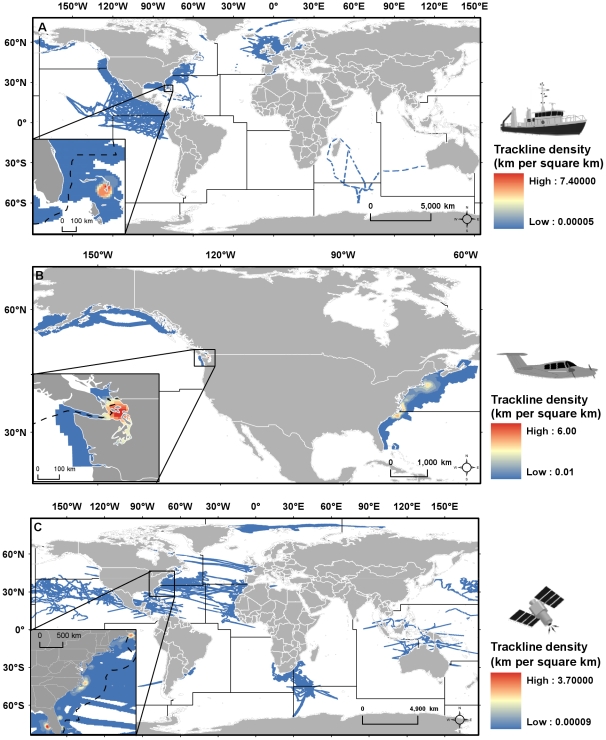
Relative density of tracklines published on SEAMAP for global FAO regions.Trackline data collected by: (A) shipboard surveys; (B) aerial surveys; and (C) satellite telemetry tag. Insets highlight the highest density per platform; FAO region borders are solid lines and US EEZ borders are dashed lines. (Ship, plane, and satellite icon credit: Tracey Saxby, IAN Image Library, ian.umces.edu/imagelibrary/).